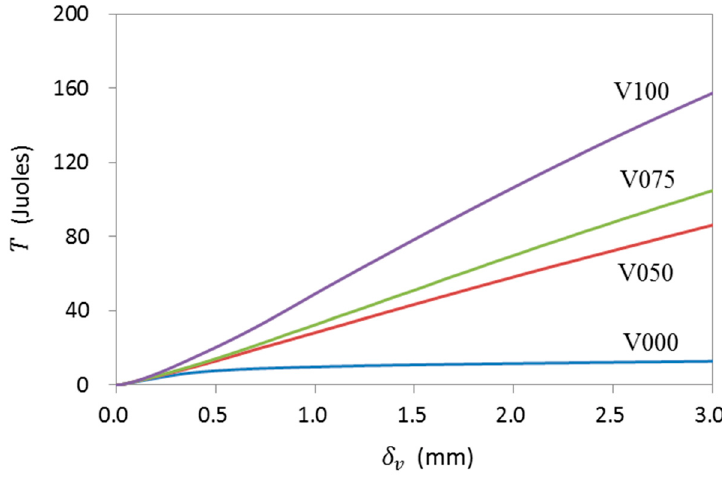
Figure 5. Energy absorption and deflection curves of the plain concrete and steel fiber-reinforced concrete (SFRC) beams obtained from the bending tests .